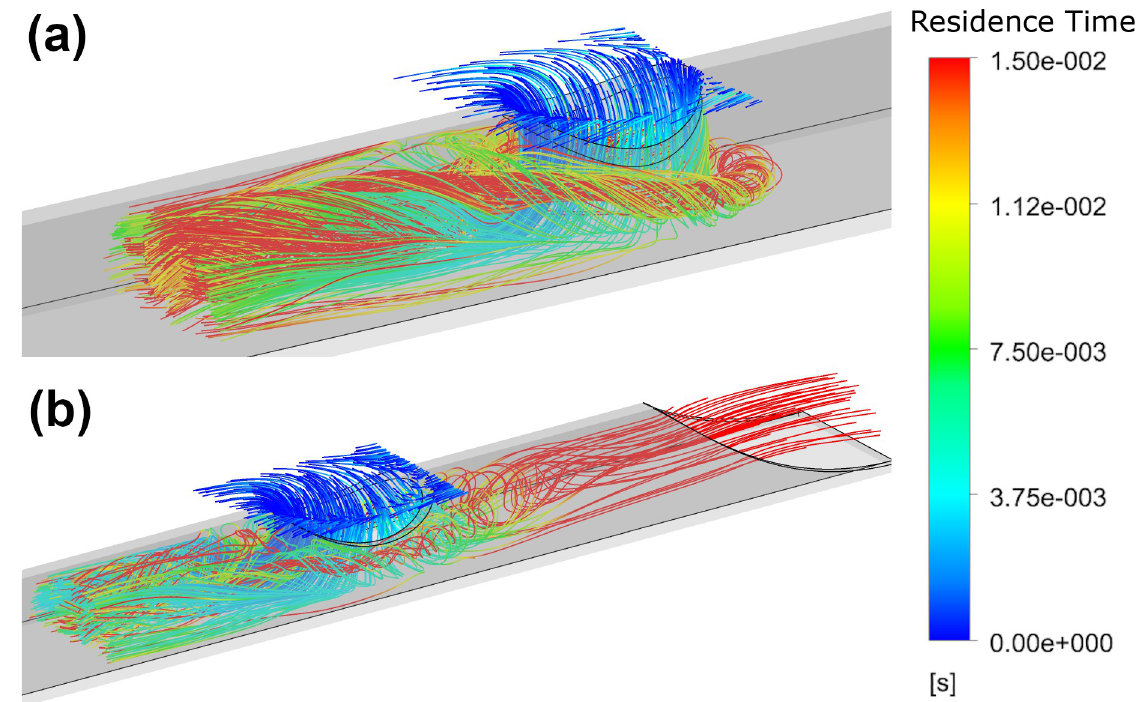
Fig 8. Residence time of platelets for the medium circular (a) and the large oval (b) side-holes.